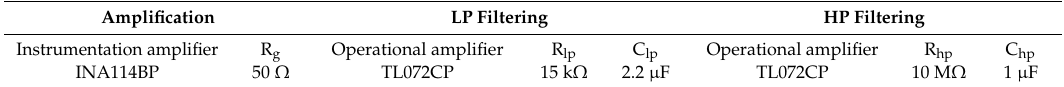
Figure 1. ( a ) Schematics for one channel of the EGG device. ( b ) Frequency characteristic for channel 1. Table 2. Components for the EGG open-source